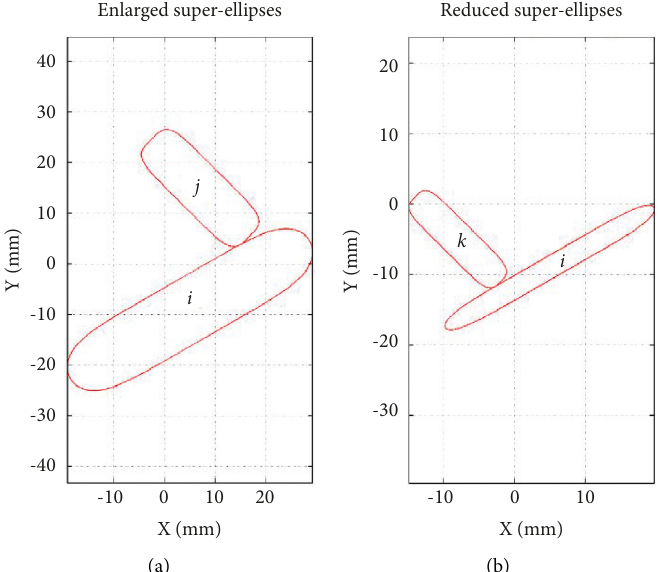
Figure 3: Contact detection of separated and overlapped particles. (a) Enlarged superellipses. (b) Reduced